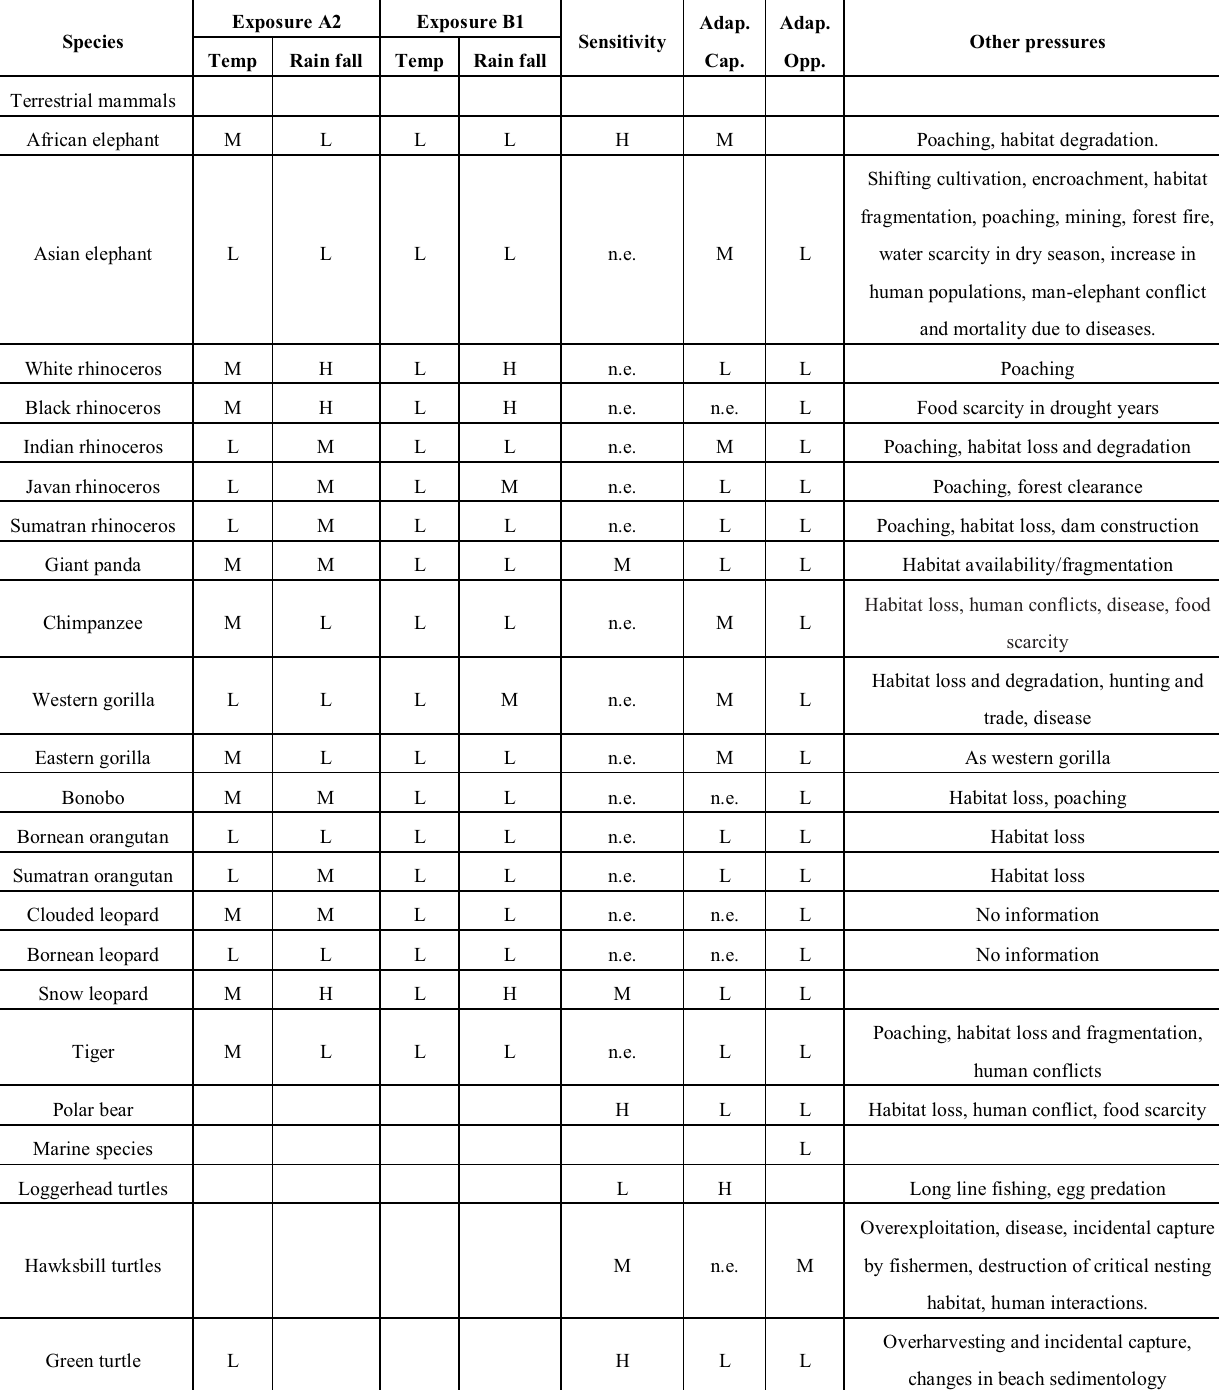
Table 6. Vulnerability of species to climate